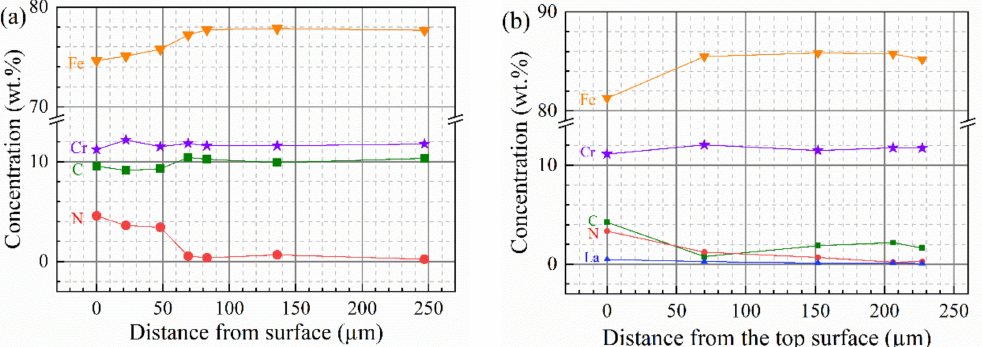
Figure 7. Element content depth distribution of the modified layer of 3Cr13 steel after plasma nitriding for 12 h ( a ) Without RE ( b ) With RE.